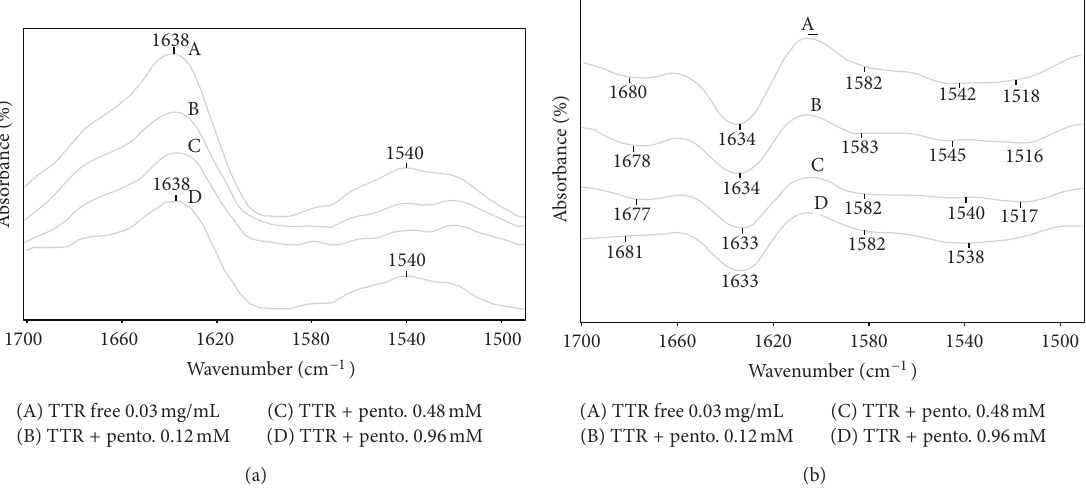
F 5: (a) Absorbance spectra of TTR-pentobarbital complexes. (b) Second derivative of TTR-pentobarbital complexes spectra. (A, B, C, and D) correspond to pentobarbital concentrations of (0.0, 0.12, 0.48, and 0.96mM), respectively.